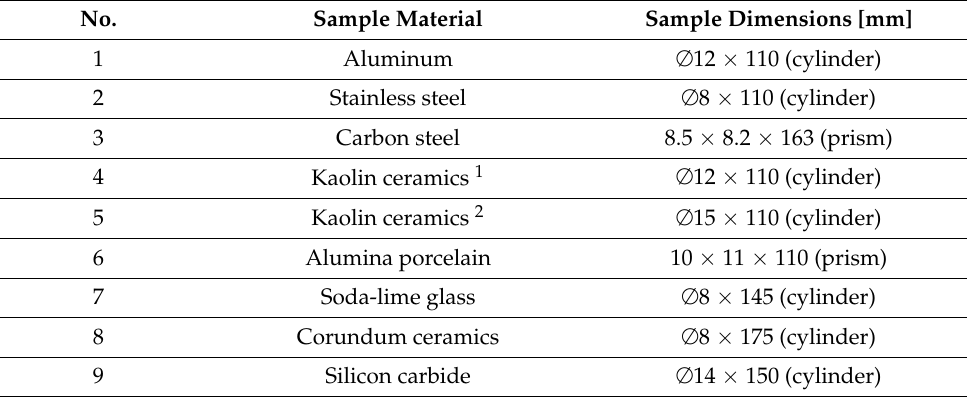
Table 1. Used materials for the measurements by SRM and IET method.